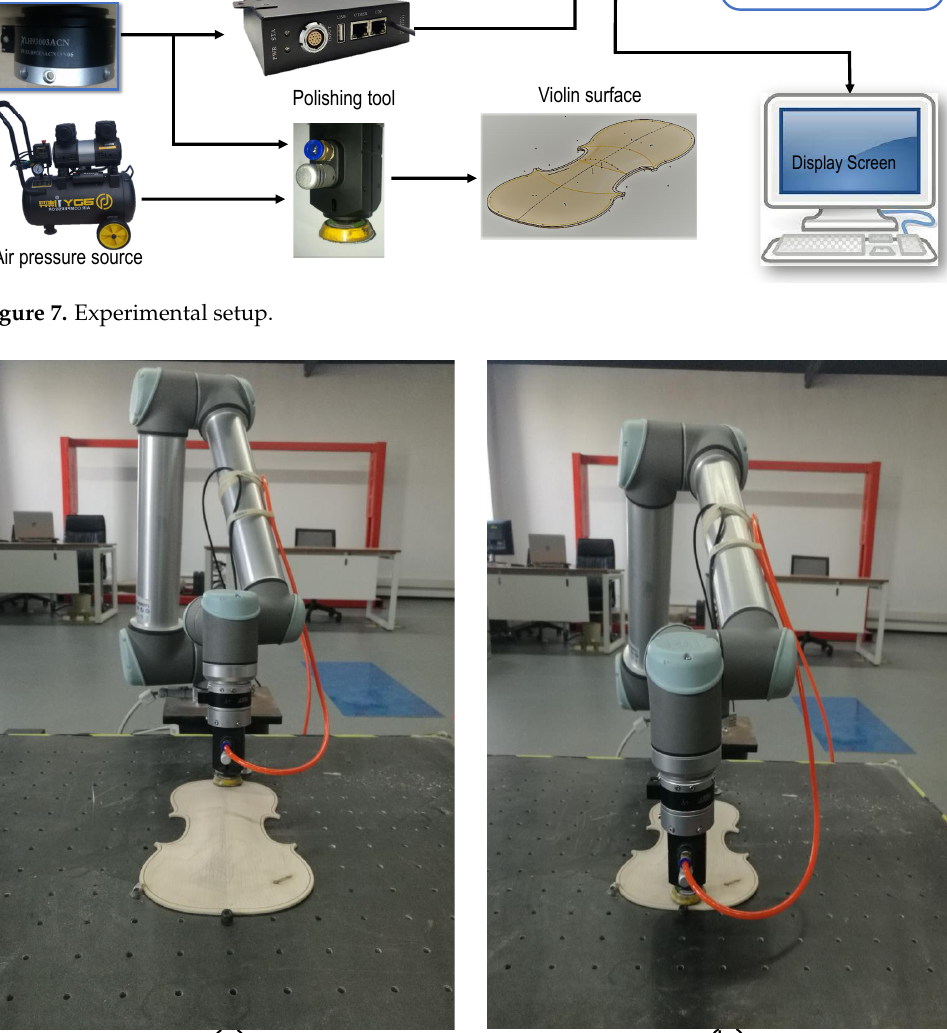
Figure 8. Experimental setup on path 1 ( a ) P0 and ( b )